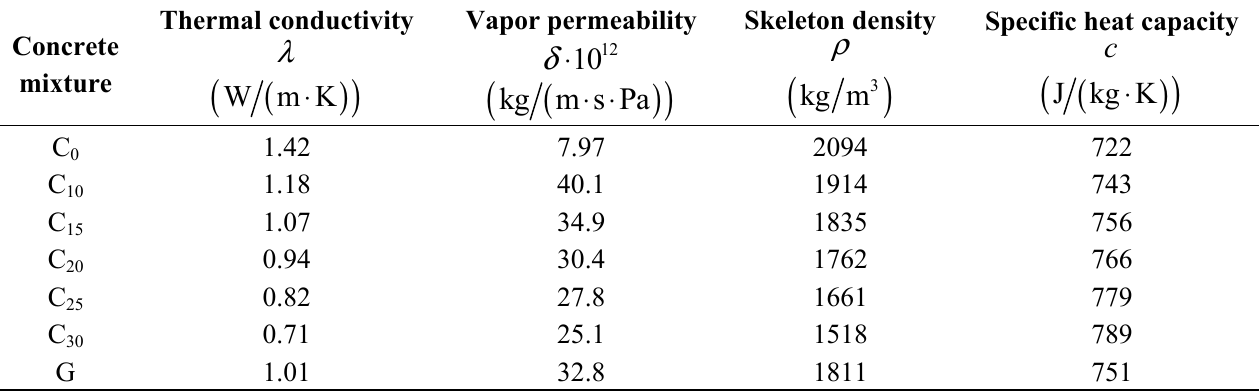
Table 5. Properties of the concrete mixtures measured